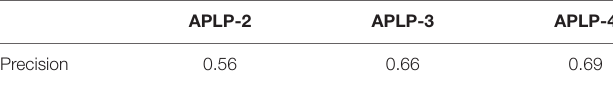
TABLE 9 | When m = 100 is the precision value of each